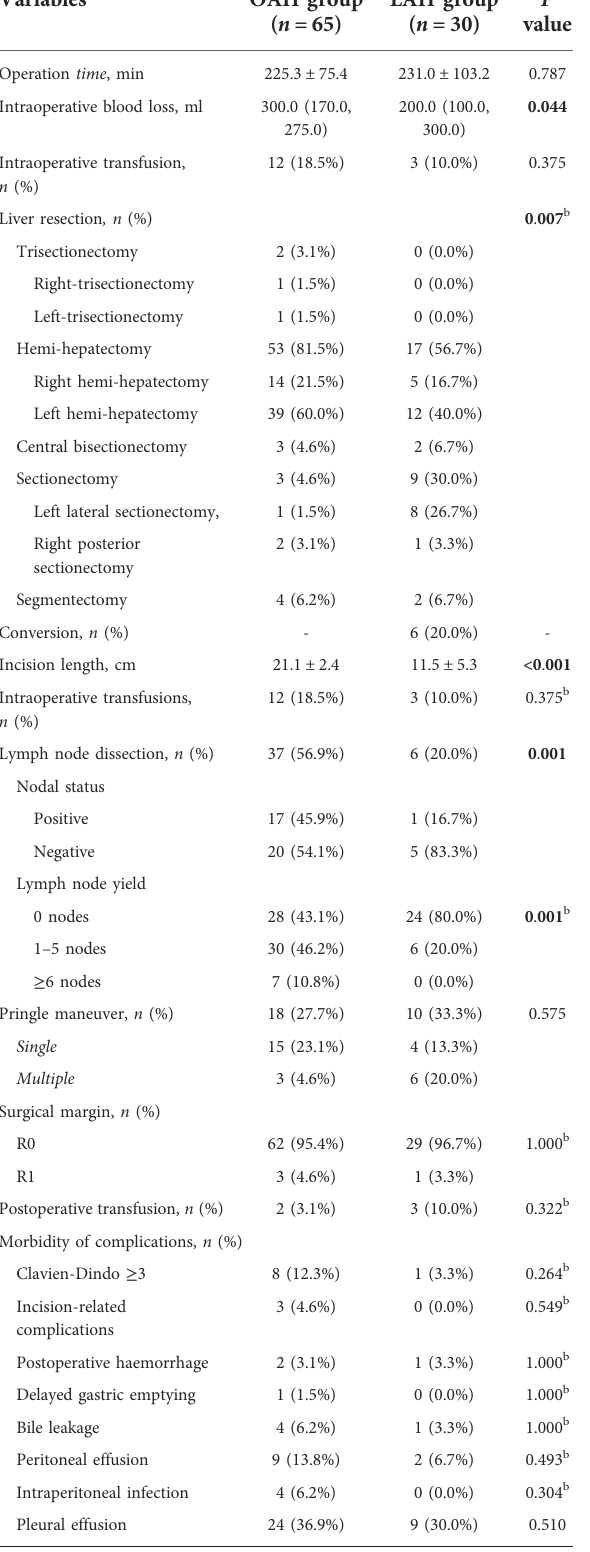
Figure 1 . Sixteen patients (24.6%) in the OAH group and seven patients (23.3%) in the LAH group received subsequent therapy, with no statistically signi fi cant difference between the two groups. In addition, the two groups had similar results in terms of the use of speci fi c subsequent therapy, such as hepatic artery chemoembolization, radiofrequency ablation,